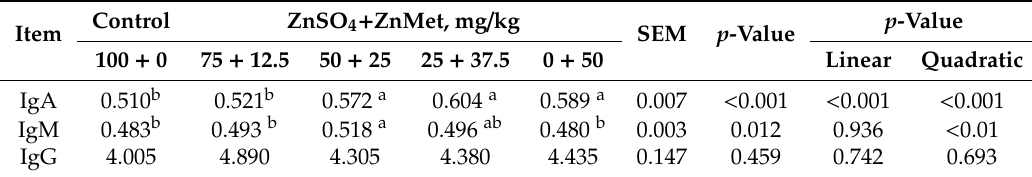
Table 5. E ff ects of dietary substitution of ZnSO 4 by low levels of ZnMet on IgA, IgM and IgG of 37- to -79-d-old piglets 1